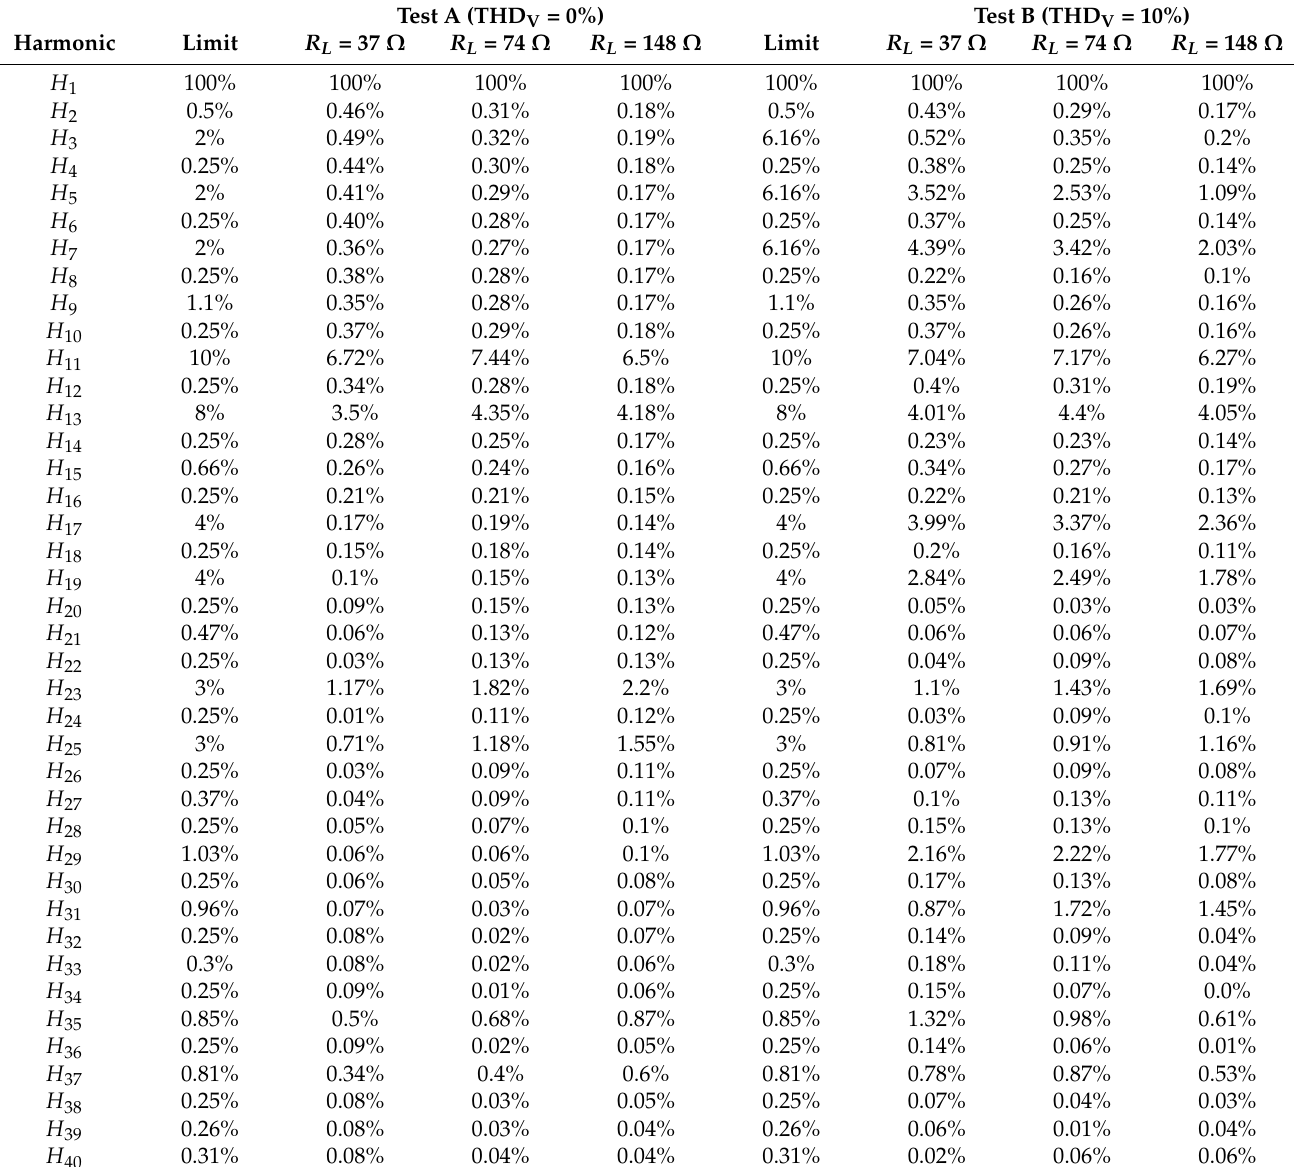
Table 6. CTU total harmonic